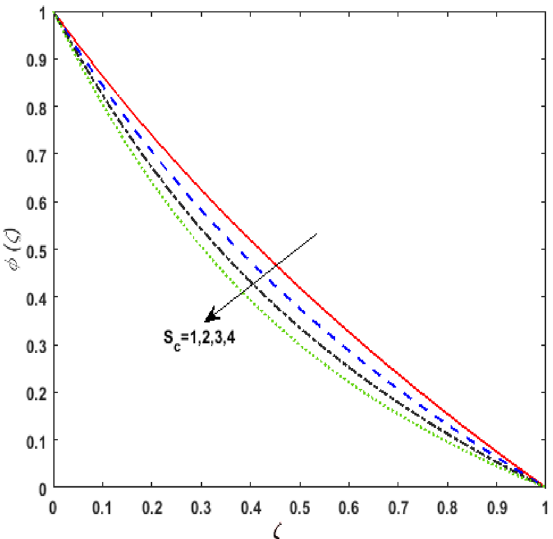
Figure 13. Effect of Schmidt number S c on concentration φ(ζ) .